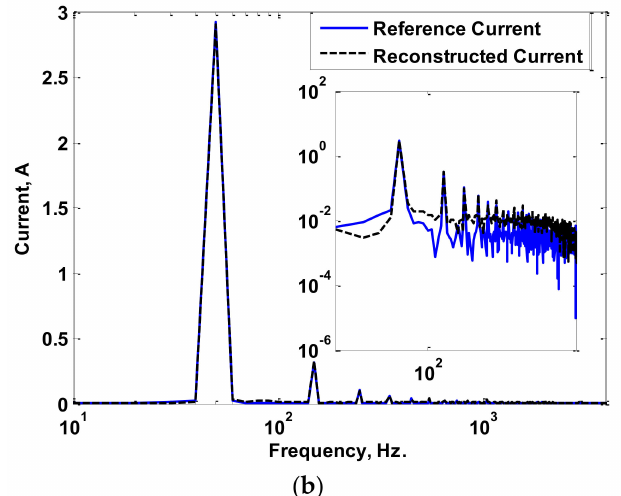
Figure 14. Reference and Reconstructed Currents of a 400 W luminaire: ( a ) Reference and Recon- structed Current Waveforms; ( b ) FFT of Reference and Reconstructed Currents.